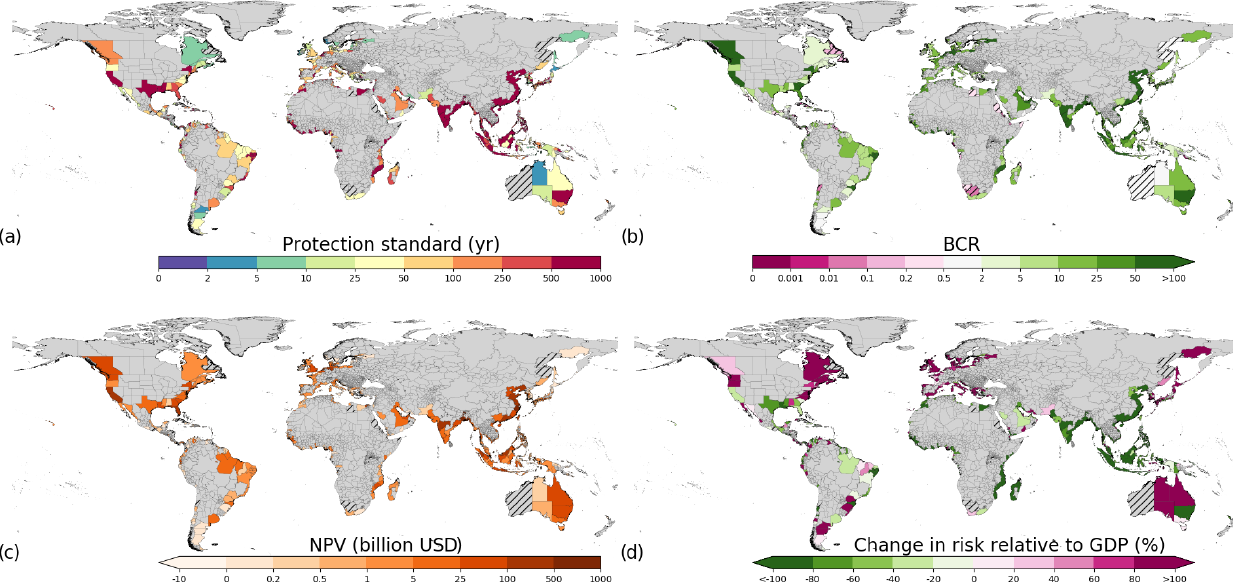
Figure 8. Optimize adaptation objective results of (a) optimal protection standards, (b) BCRs, (c) total NPV, and (d) change in risk relative to GDP for RCP4.5–SSP2. Regions where no optimal protection standards are found are indicated with hatched lines, and regions with no data are indicated in